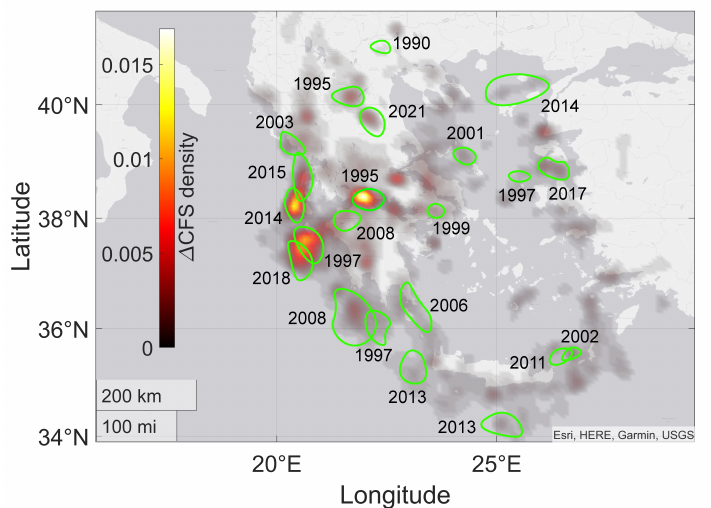
Figure 4. ∆ CFS density map for seismicity in Greece, NOAIG Catalog, 1990–2021, M L ≥ 2.0. Highest density areas are located on the Greek Ionian Islands along Hellenic Trench and along normal fault system of Gulf of Corinth.